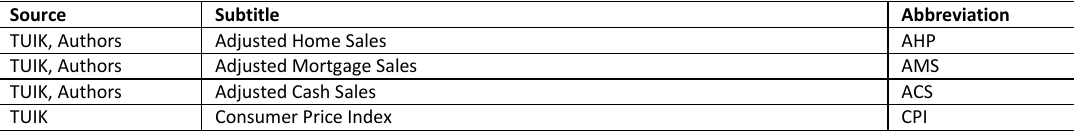
Table 1 Sources, data and